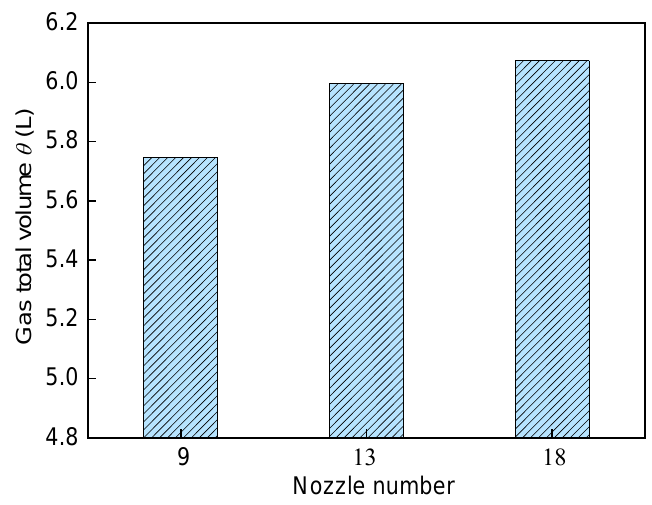
Figure 13. Effect of different nozzle numbers on the predicted gas total volume in the bath.